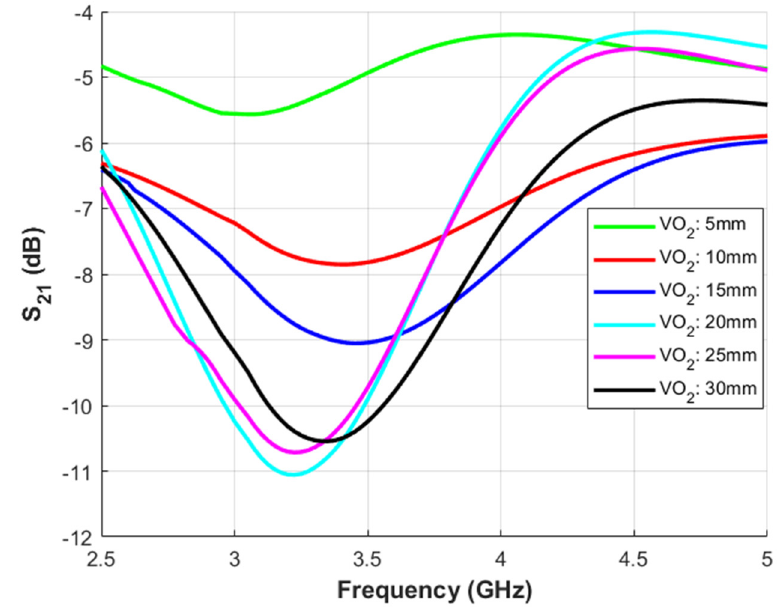
Figure 11. The graph of the measured transmission coefficient of the double diffracted dipole pattern on VO 2 over sapphire wafer with varying separation distance at L = 39 mm and W = 3 mm.